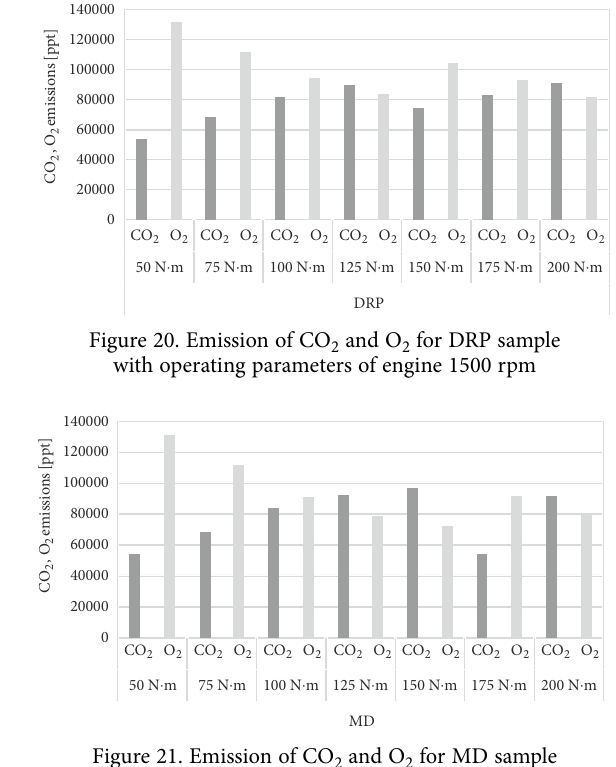
Figure 21. Emission of CO 2 and O 2 for MD sample with operating parameters of engine 1500